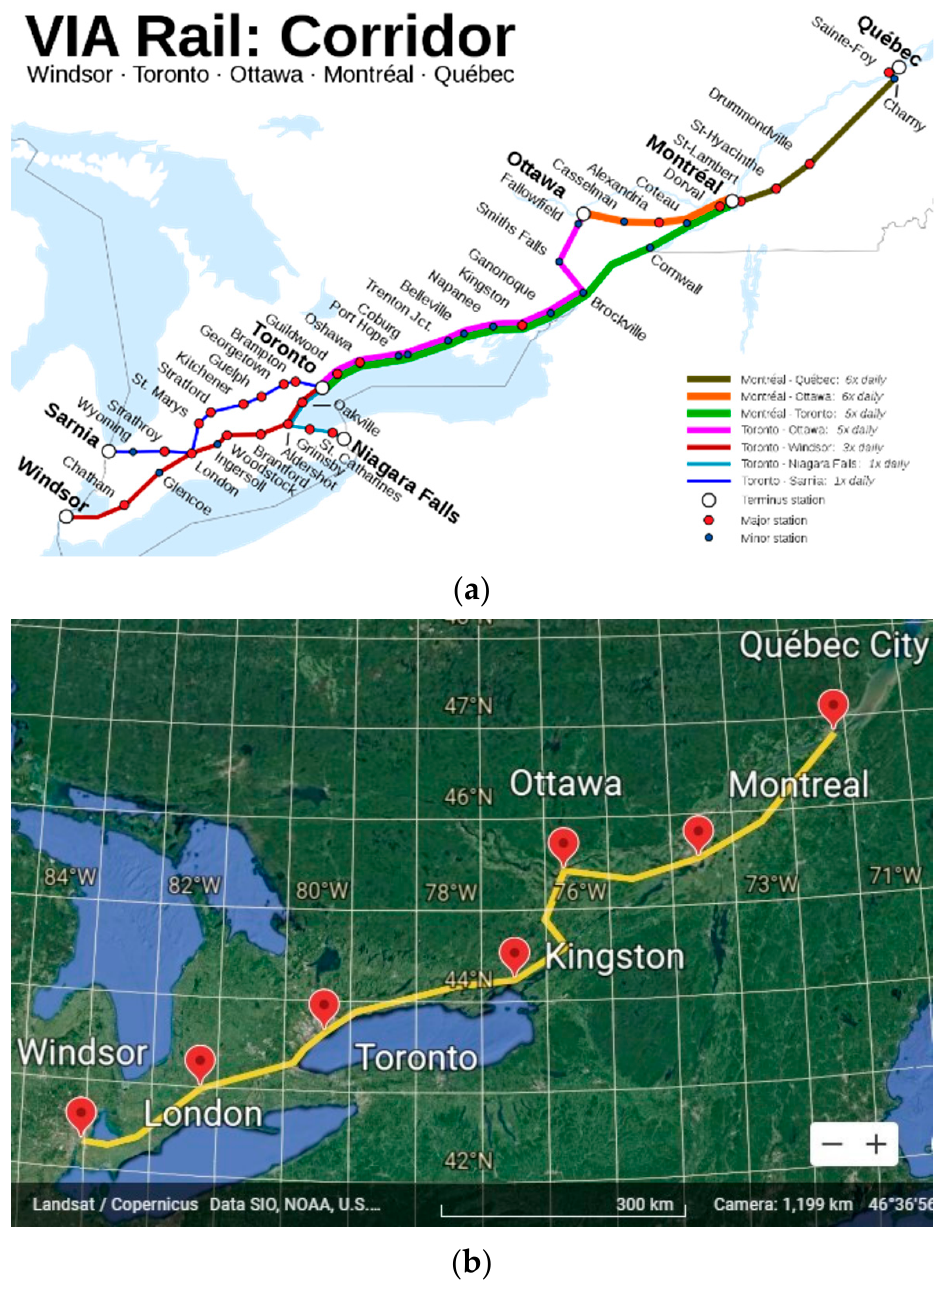
Figure 1. Study area ( a ) Quebec City-Windsor Corridor map [22] ( b ) main rail stations [23]. The climate data used herein were obtained from the database of the Meteorological Service of Canada, which is a division of Environment and Climate Change Canada and primarily provides public meteorological information and weather forecasts. The database contains data from analysis systems along with output from many of the Canadian Meteorological Centre’s Numerical Weather Prediction models. It provides estimates of